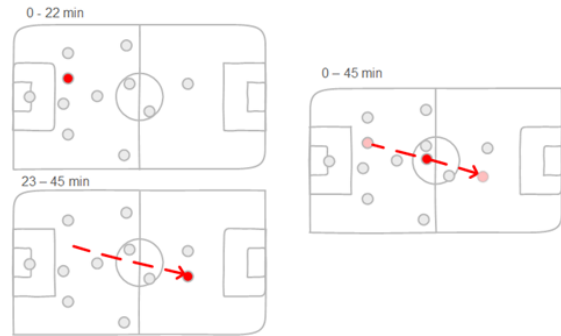
Figure 7. Left: the RTL of one team (grey dots) for two consecutive time periods of the first half of the match. The highlighted player played in different positions in each of them. Right: a single RTL for the complete half is not able to show the change in